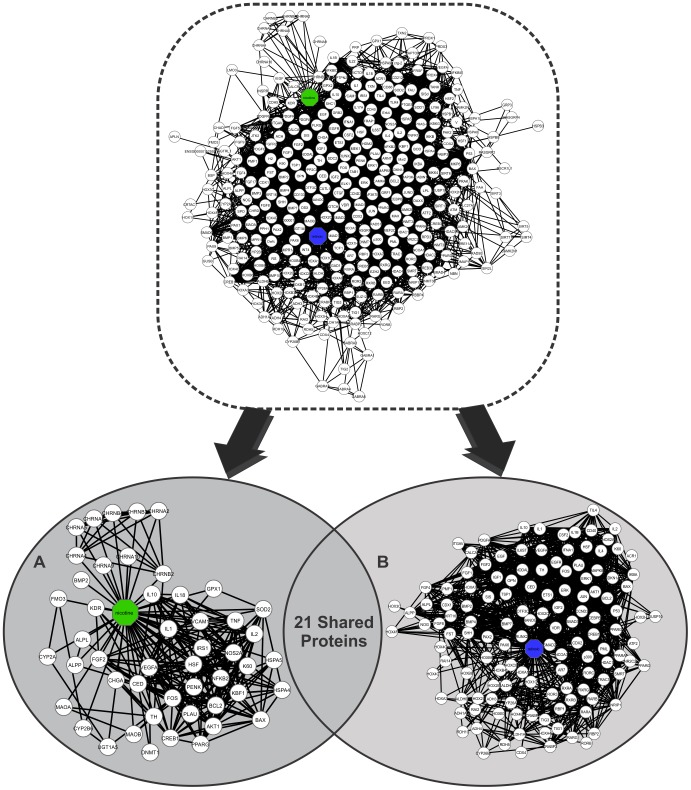
A binary network of the interactions between chemical compounds and proteins generated by the program Cytoscape 2.6.3, which contained 330 proteins and 4078 connections.Nicotine appears in the network as the green node, and RA appears as the blue node. White nodes are connected to both compounds are proteins. A) A subnetwork generated by the program Cytoscape containing 49 nodes and 281 edges and showing the proteins with direct connections with nicotine. B) A subnetwork generated by the program Cytoscape containing 130 nodes and 1,471 edges and showing the proteins that make direct connections with RA.